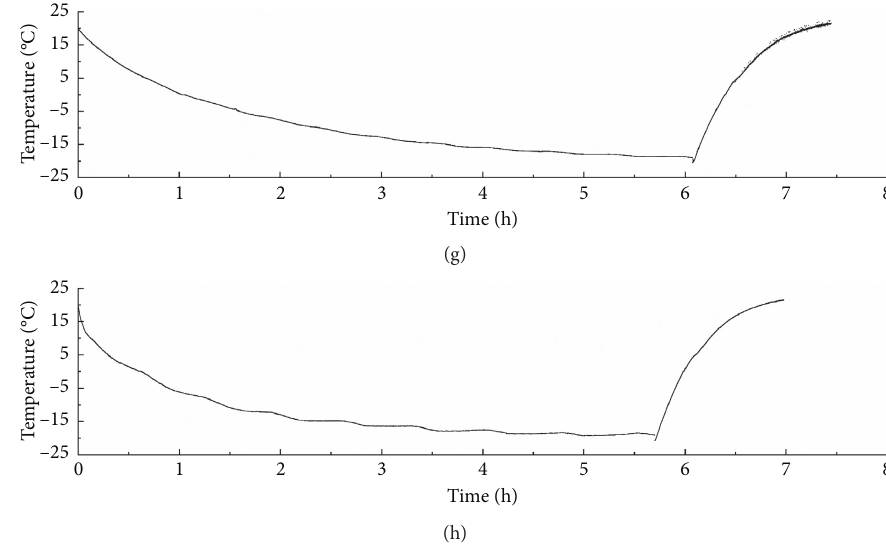
Figure 3: Variation of the internal temperature of the rock sample under different freezing and thawing cycles. (a) n � 5; (b) n � 10; (c)